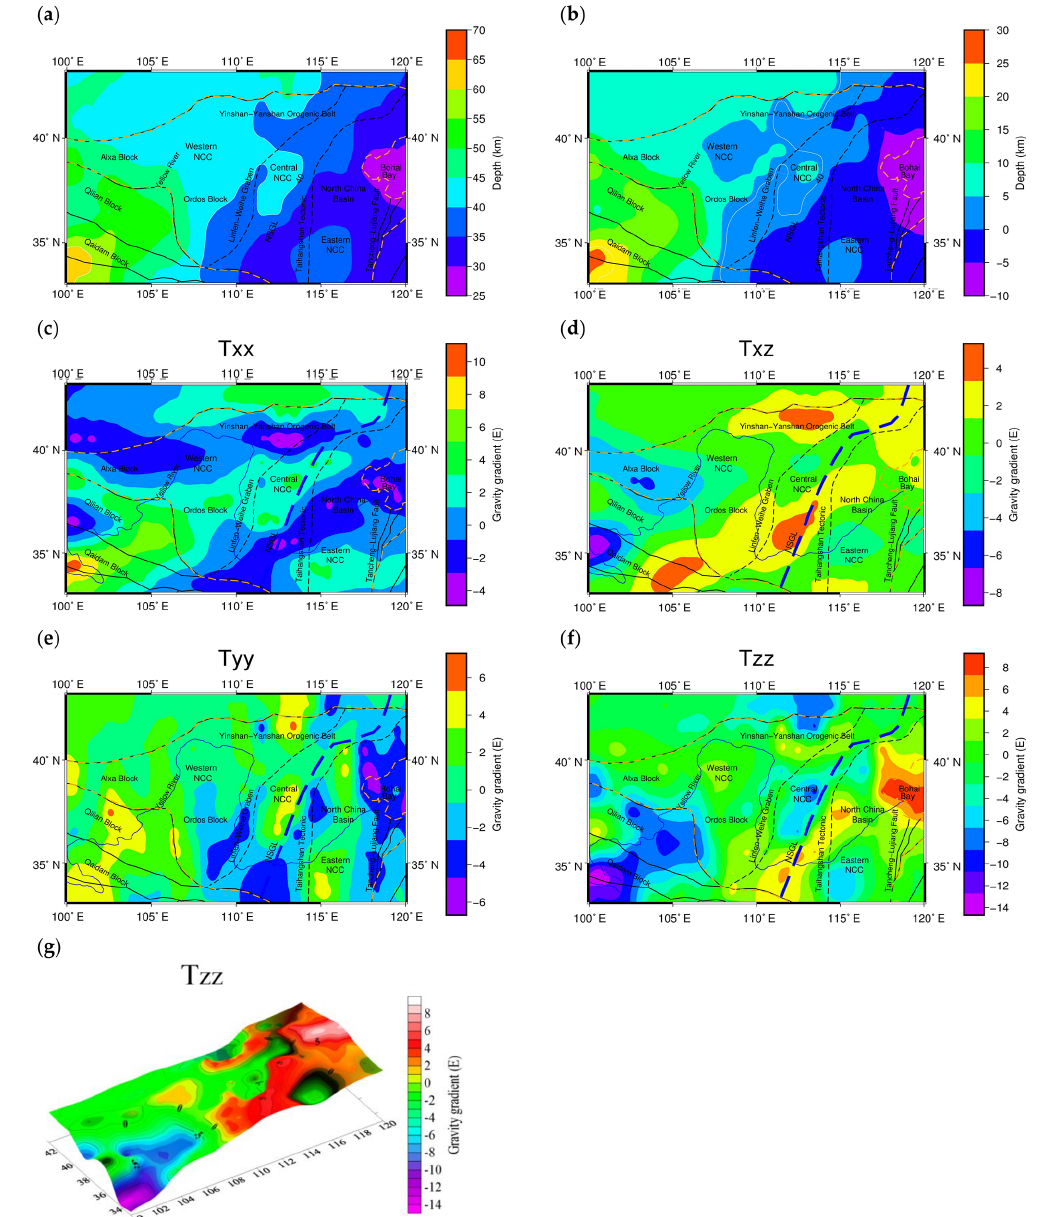
Figure 11. (a) Moho interface of the NCC. (b) Moho interface undulation of the NCC. (c) The anomalous gravity gradient effect caused by the Moho interface undulation are shown in (c) T xx , (d) T xz , (e) T yy and (f) T zz . (g) The 3D gravity gradient effect T zz of the Moho interface undulation is